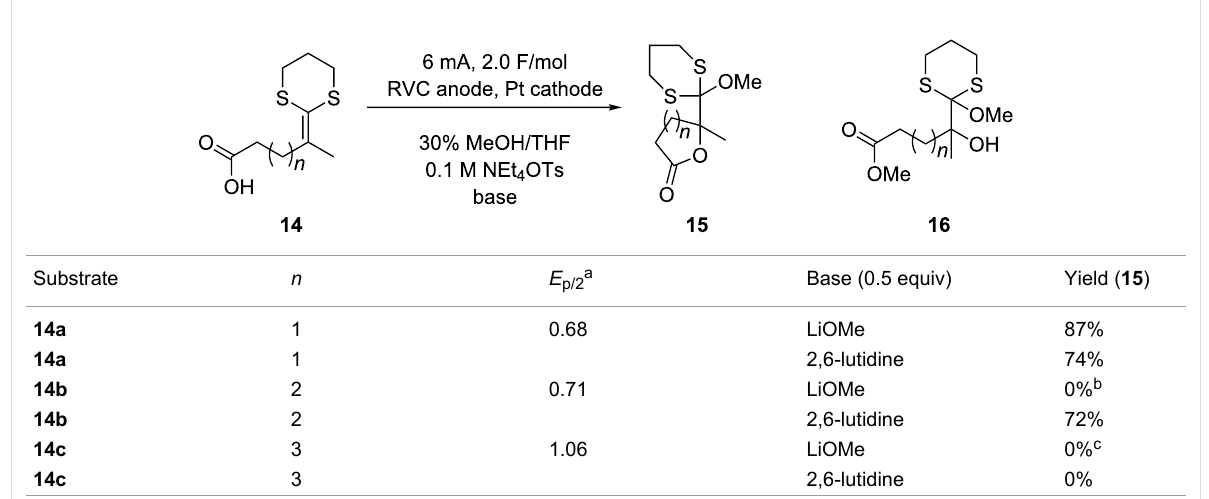
Table 1: Anodic coupling of ketene dithioacetals and carboxylic acids.